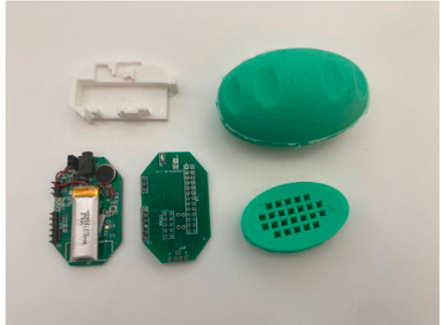
Figure 3. Smart Sensor Egg. The device is about 60 mm tall and weighs 50 g. ( Left side ): electronic board with an integrated pressure sensor and accelerometer. ( Right side ): silicone cover.